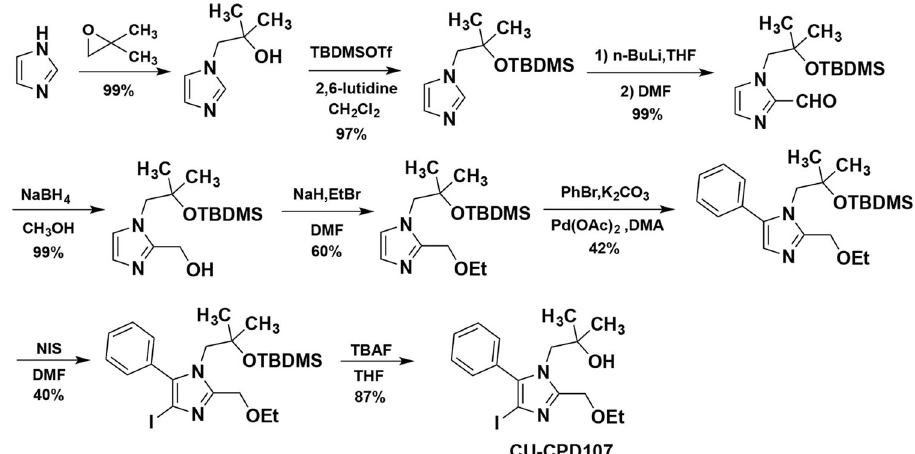
Fig. 2 Representative synthetic route of the imidazoquinoline derivatives, taking CU-CPD107 as an example. CU-CPD107 was synthesized in eight steps.